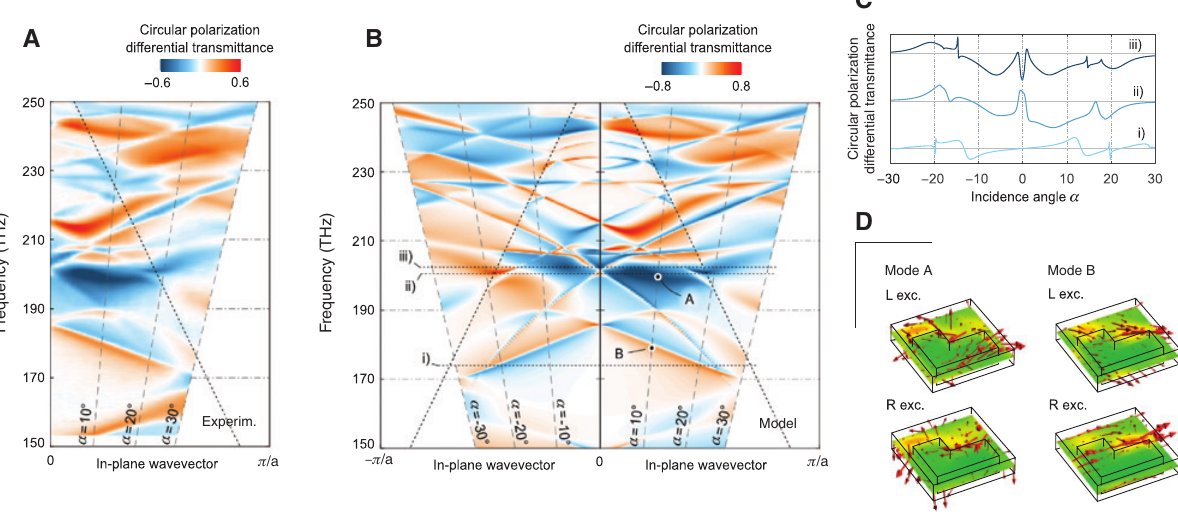
Figure 2: The CPDT mapped in the frequency-wavevector space for our metasurface. Measured (A) and modeled (B) circular polarization differential transmittance (CPDT) band structure of the metasurface. A rich pattern originating from the interplay between guided mode resonances and antenna-like resonances is observed. The diagonal short-dash lines represent the diffraction threshold: below those lines the sample operates in the proper metasurface regime. By tuning the incidence angle α the first Brillouin zone is probed along a high-symmetry direction (see also Figure 1A). Notice that the CPDT does not fulfil the relation CPDT( α ) = −CPDT(− α ). Panel (C) highlights this behavior, for three optical frequencies identified in panel (B). Panel (D) illustrates the electromagnetic energy density (color map: green = low, orange = high) and the Poynting vector (red arrows) inside the metasurface unit cell for modes A and B (see panel (B) for their definition) and for both circular polarization states of the illuminating beam. Notice that in mode B the Poynting vector follows a well-defined direction, witnessing the presence of a traveling wave, while in mode A it “winds up” around the L-shaped inclusion, indicating a localized